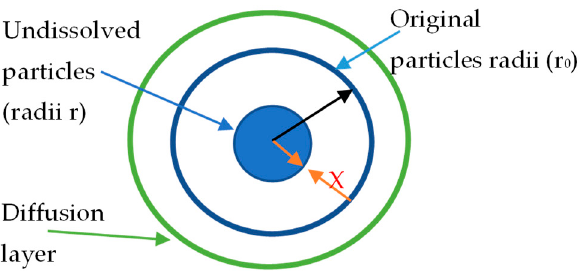
Figure A1. Scheme of an ideal mineral particle in the dissolution process.